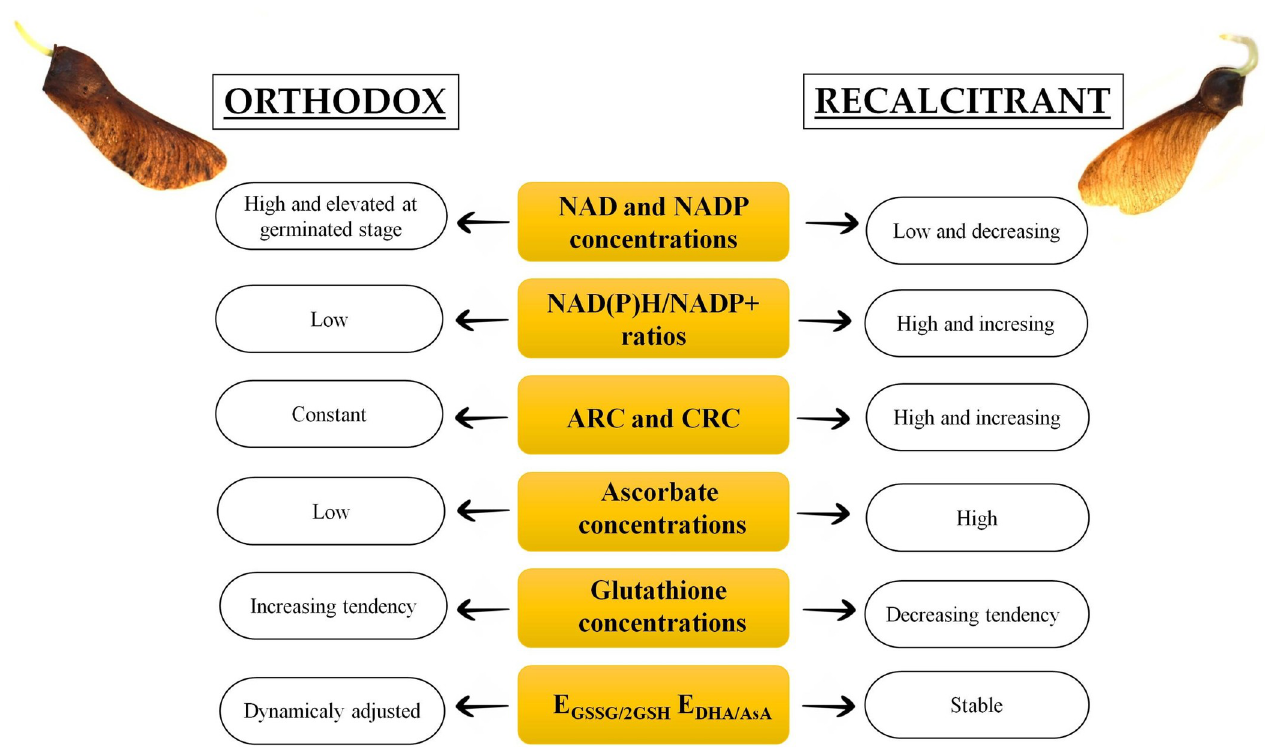
Fig 8. A scheme of strategies describing distinct redox regulation during germination of orthodox (Norway maple) and recalcitrant (sycamore) seeds.